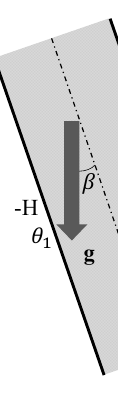
Figure 1. Physical sketch of the system.